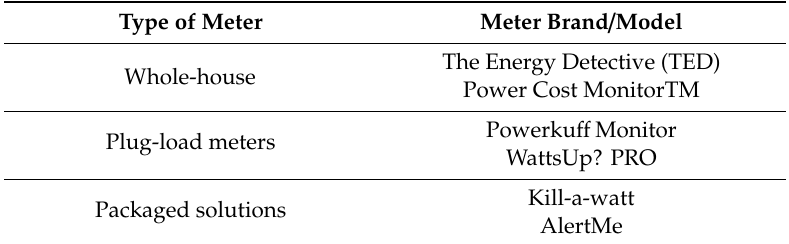
Table 1. Commercially available residential electricity meters by type.